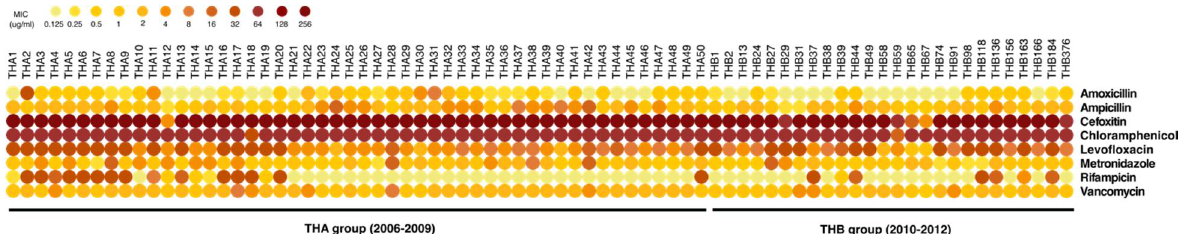
Figure 4. The MIC values of C. difficile isolates in Thailand. Eight antibiotics were used to investigate MIC values of C. difficile isolates in THA group (n = 50) and THB group (n = 26) using broth dilution method. The colors represent different MIC values. Table 2. Antibiotic susceptibility patterns of C. difficile isolates in Thailand.